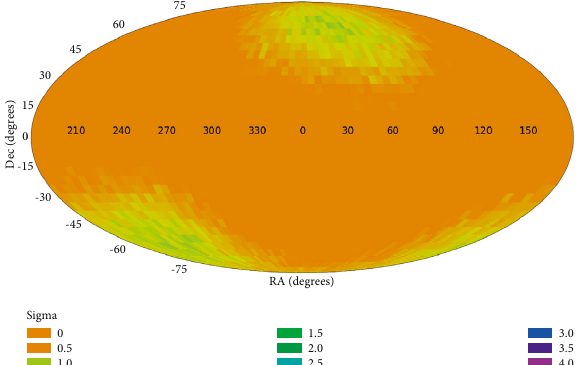
Figure 5: The probability of a dipole axis from different ( α , δ ) when the galaxies are assigned with random spin